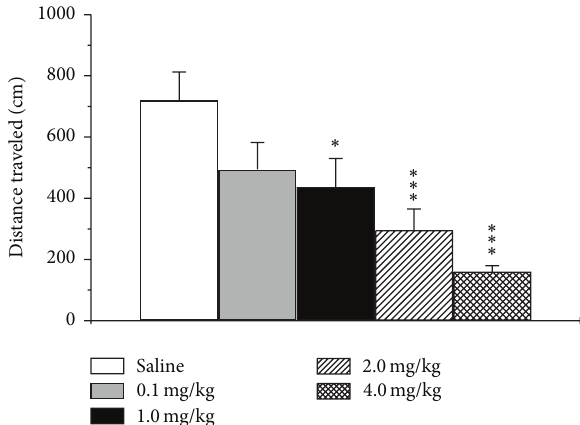
Figure 1: Effect of different doses of selective 5-HT 2 C receptor agonist MK-212 on distance traveled in the open field test in CBA mice. The data are presented as the mean ± SEM ( 𝑛 = 8 per group; ∗ 𝑝 < 0.05 , ∗∗∗ 𝑝 < 0.001 versus saline group).